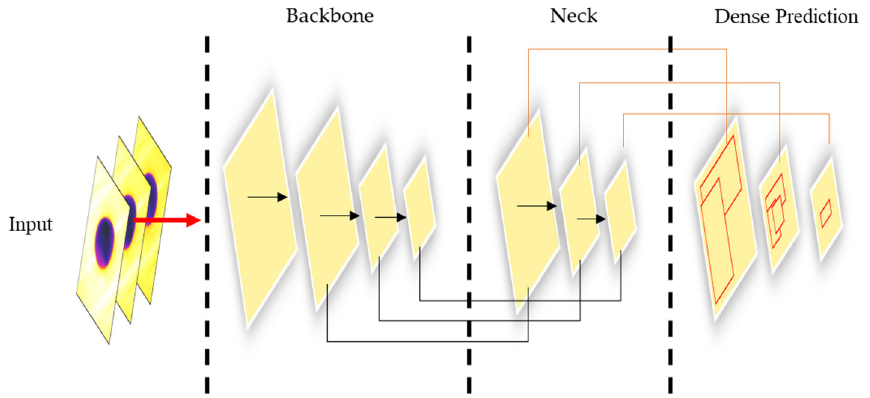
Figure 5. One-stage detectors YOLOv4, YOLOv5, and EfficientDet basic architecture for the thermal imagery-based datasets.